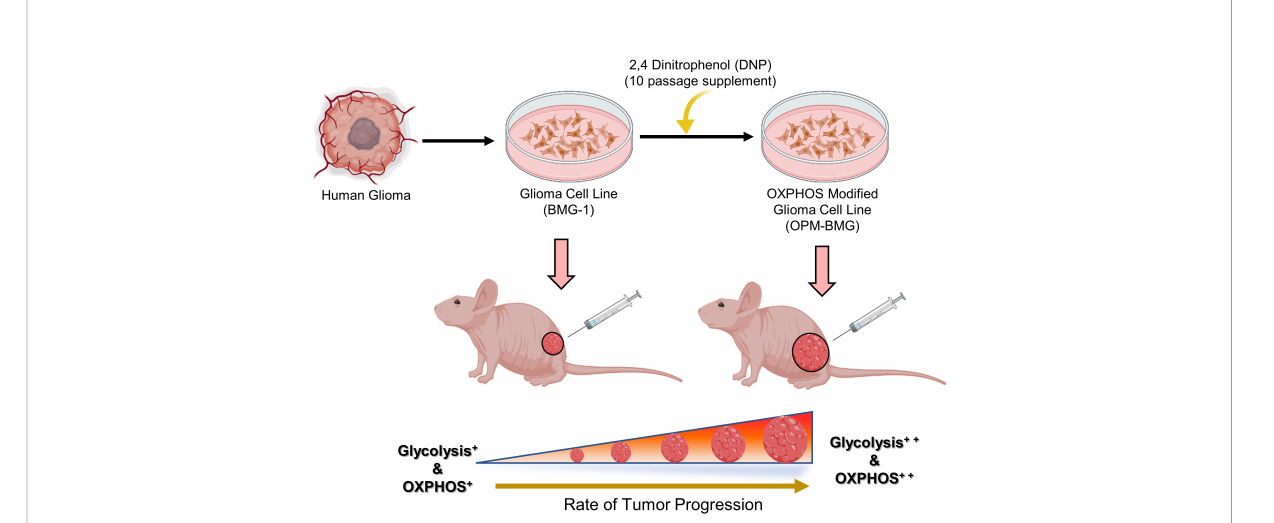
FIGURE 7 (Summary Figure): Graphical illustration indicates the prolonged effect of mitochondrial uncoupler on the energy metabolism of glioma cells. The human glioma-derived cell line BMG-1 was treated with DNP to modify the electron transport chain, which resulted in a phenotype of dual-state hyper- energy metabolism characterized by increased glycolysis ++ and OXPHOS ++ compared to its parental phenotype (BMG-1) of low glycolysis + and OXPHOS + . Tumor xenograft investigation shows that OPM-BMG cells with dual-state hyper-energy metabolism have increased tumorigenic potential and accelerated tumor growth, compared to its parental phenotype. (The graphical illustration was generated using Biorender